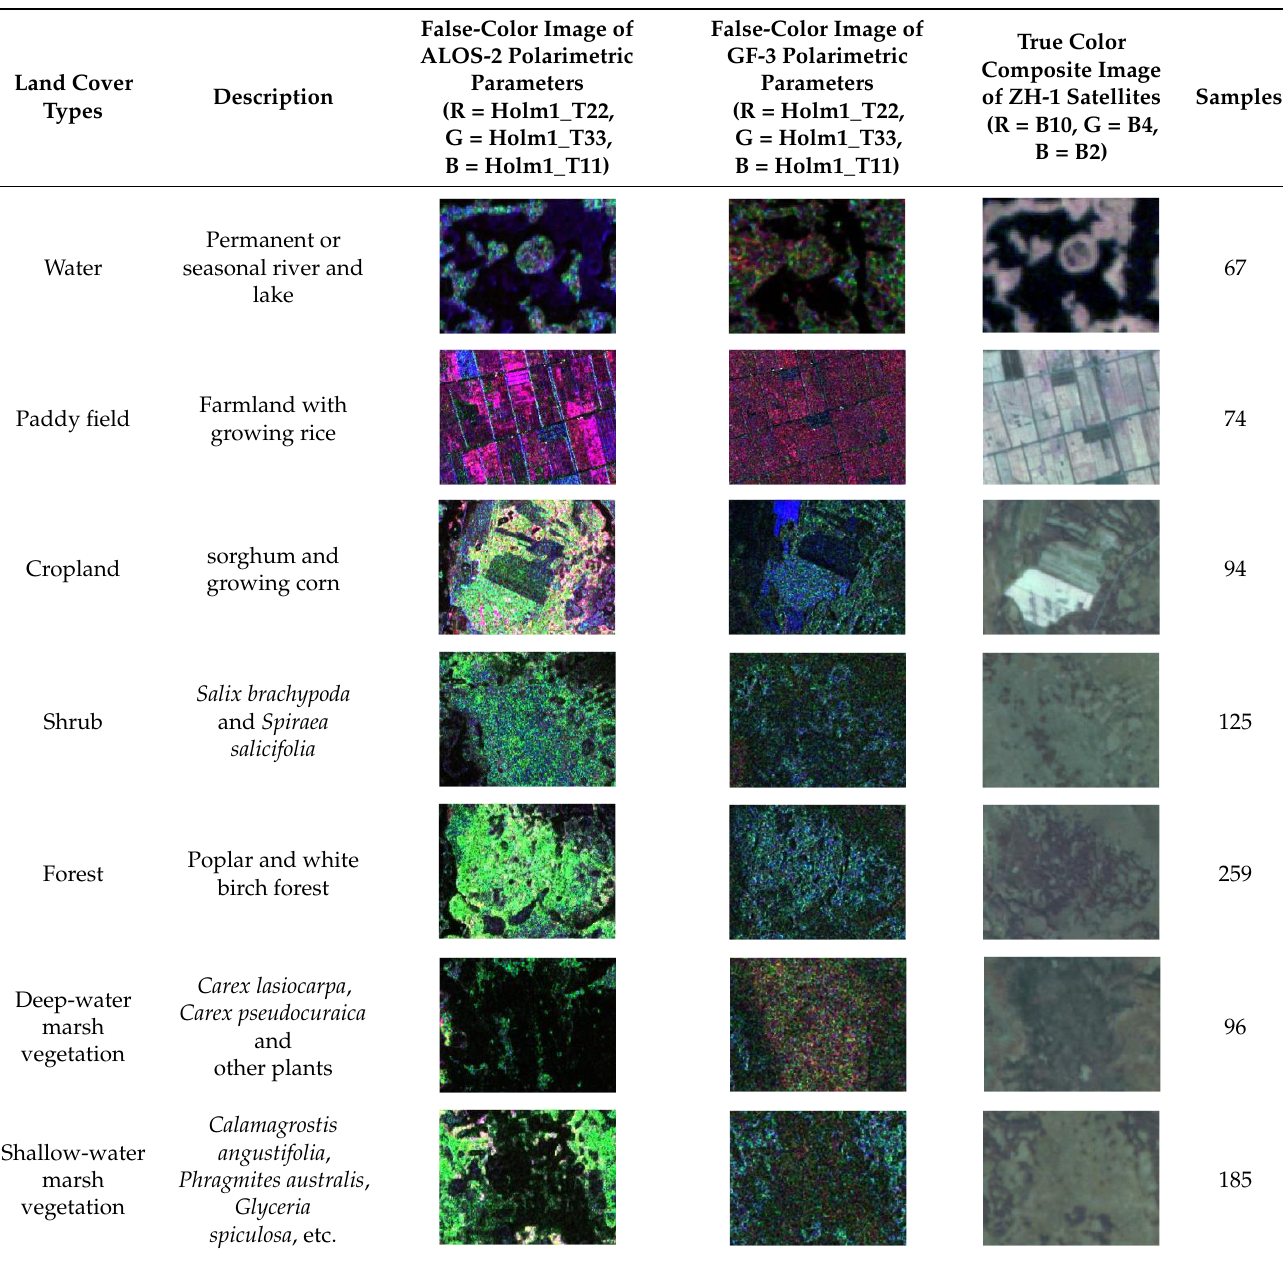
Table 2. Summary of the classification system and the number of sample data.